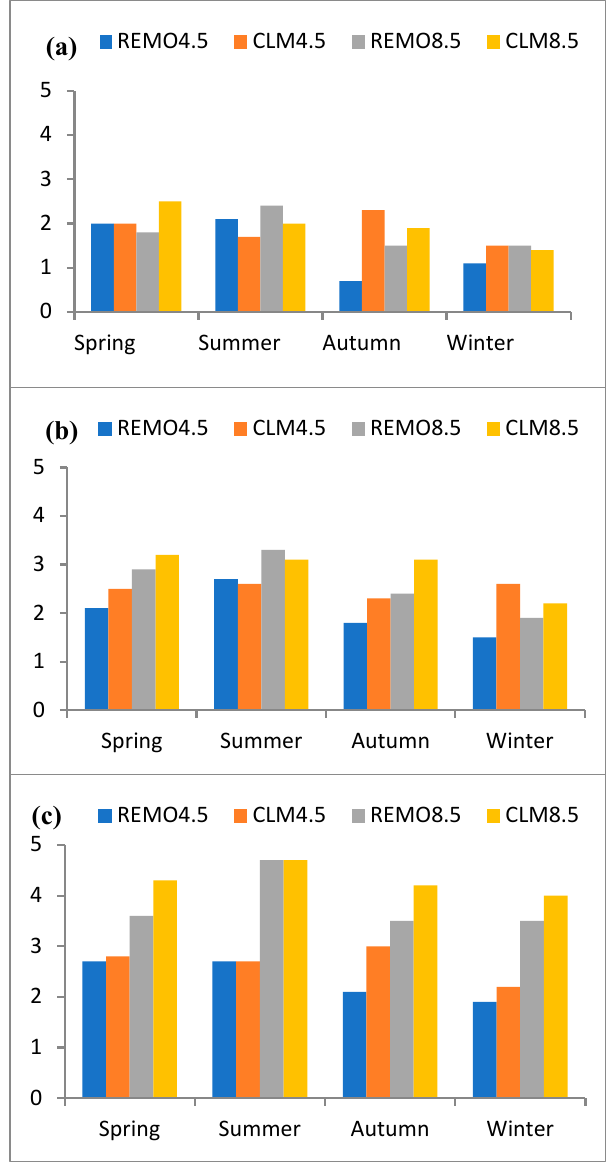
Figure 6. Changes in temperature as percentual differences compared with baseline for: ( a ) short, ( b ) mid, and ( c ) long term. Instead, for the precipitation (Figure 7), the projections reveal an opposite trend compared with the baseline, with increases by up to 68%, particularly during winter,